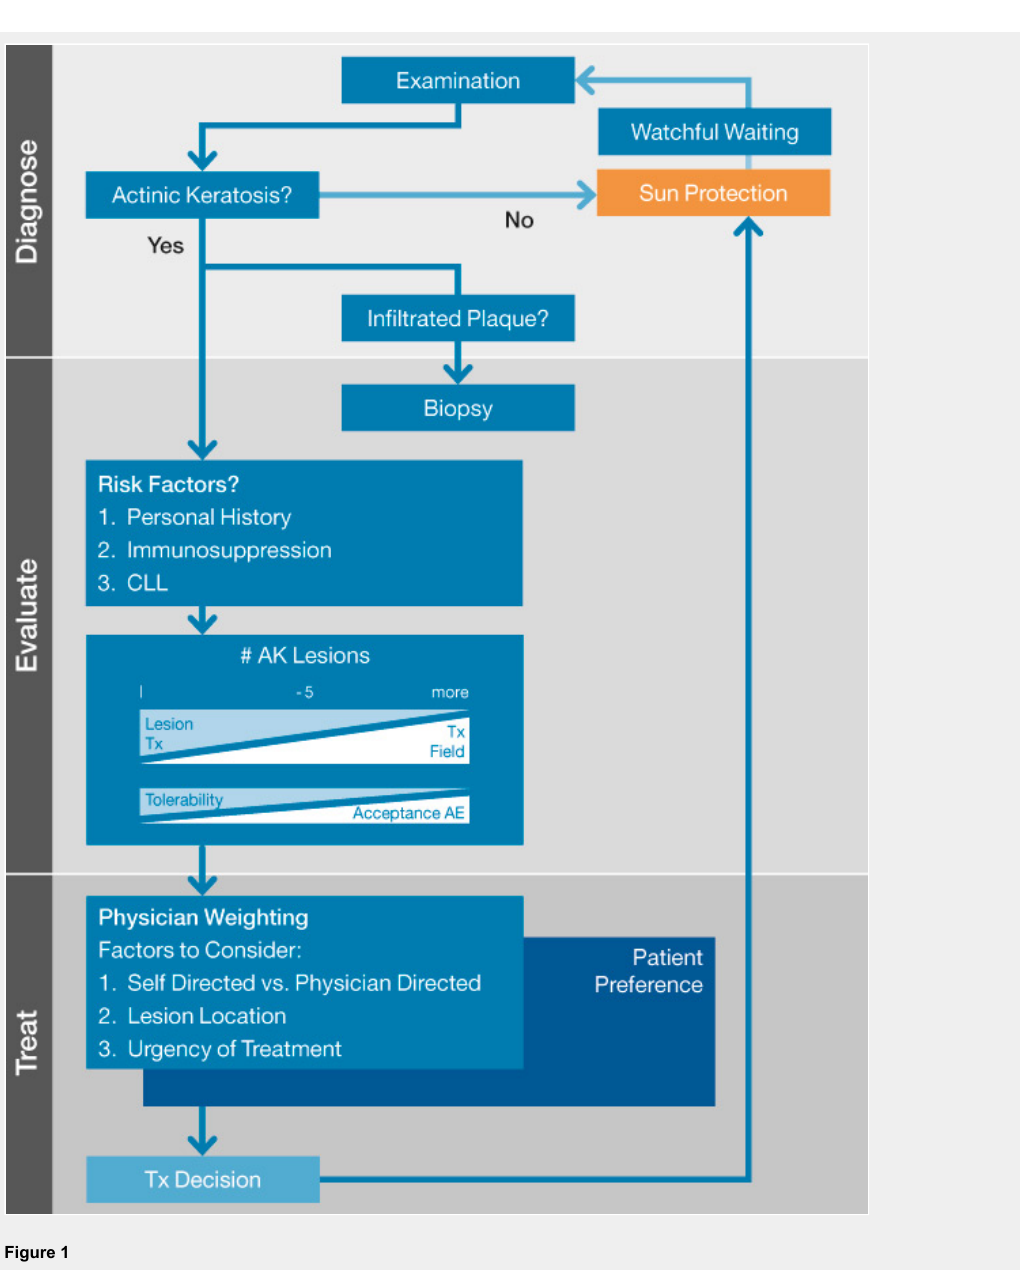
Actinic keratosis and field cancerization treatment algorithm The algorithm is intended to aid in the treatment decision process for actinic keratosis and field cancerization and is not intended to replace a physician’s best judgement on the most appropriate treatment path for each individual